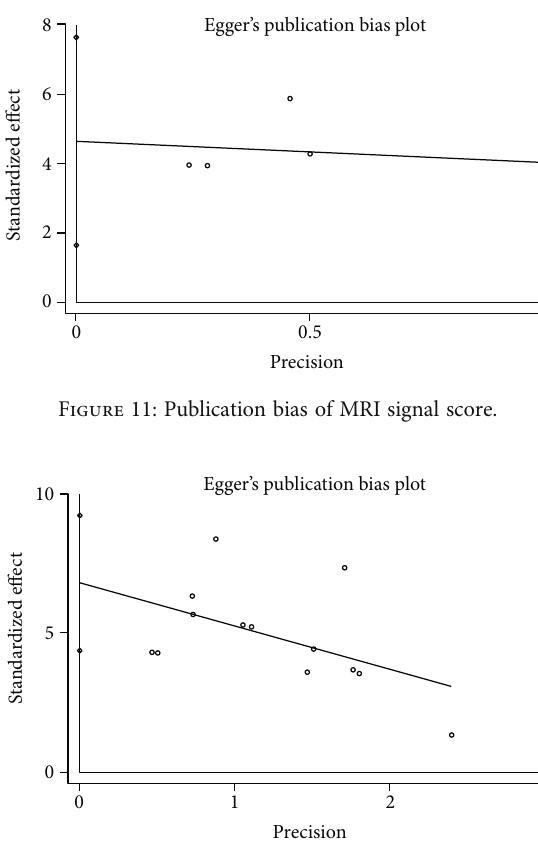
Figure 9: Publication bias of disc height.